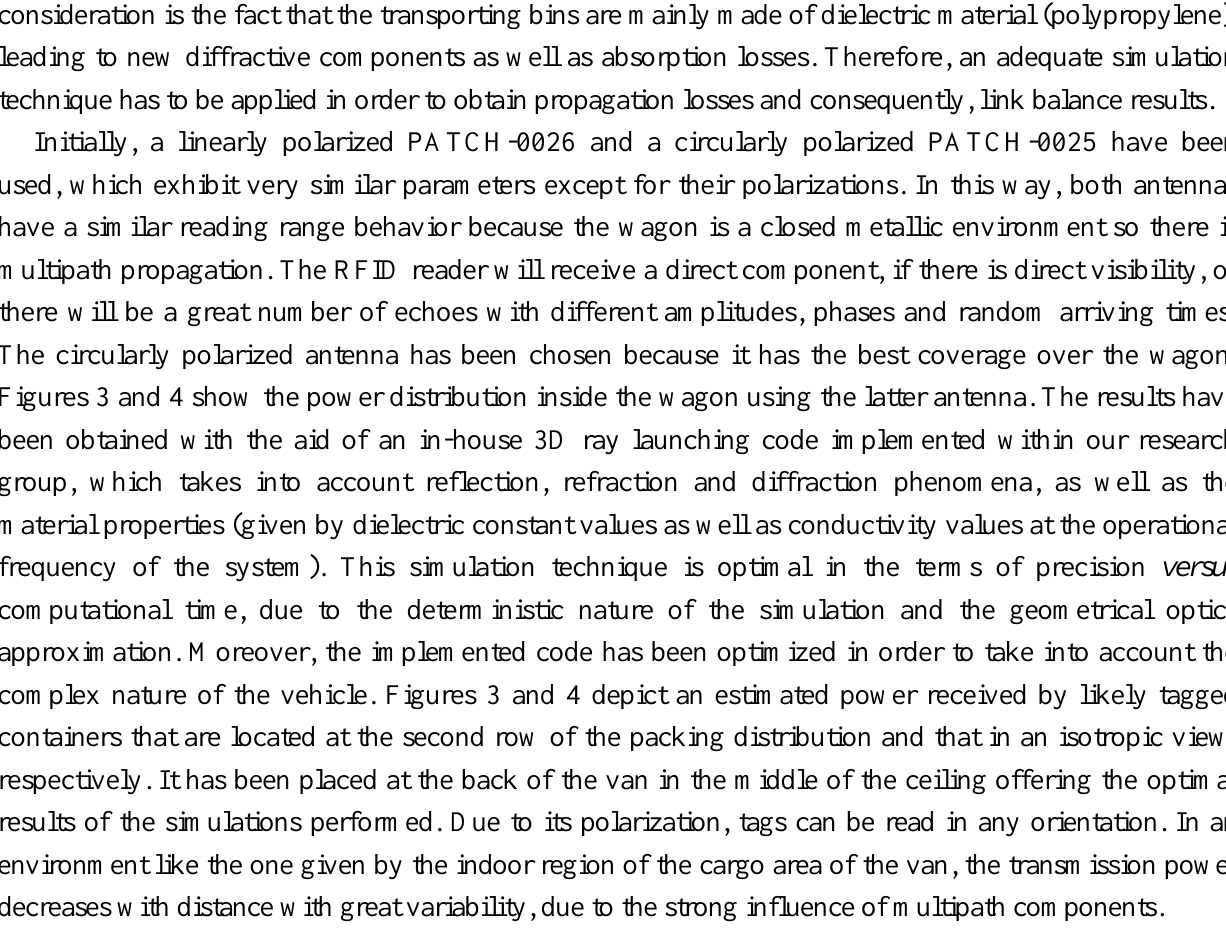
Figure 3. Estimation of received power [dBm] on the second floor of containers, obtained by full 3D ray launching